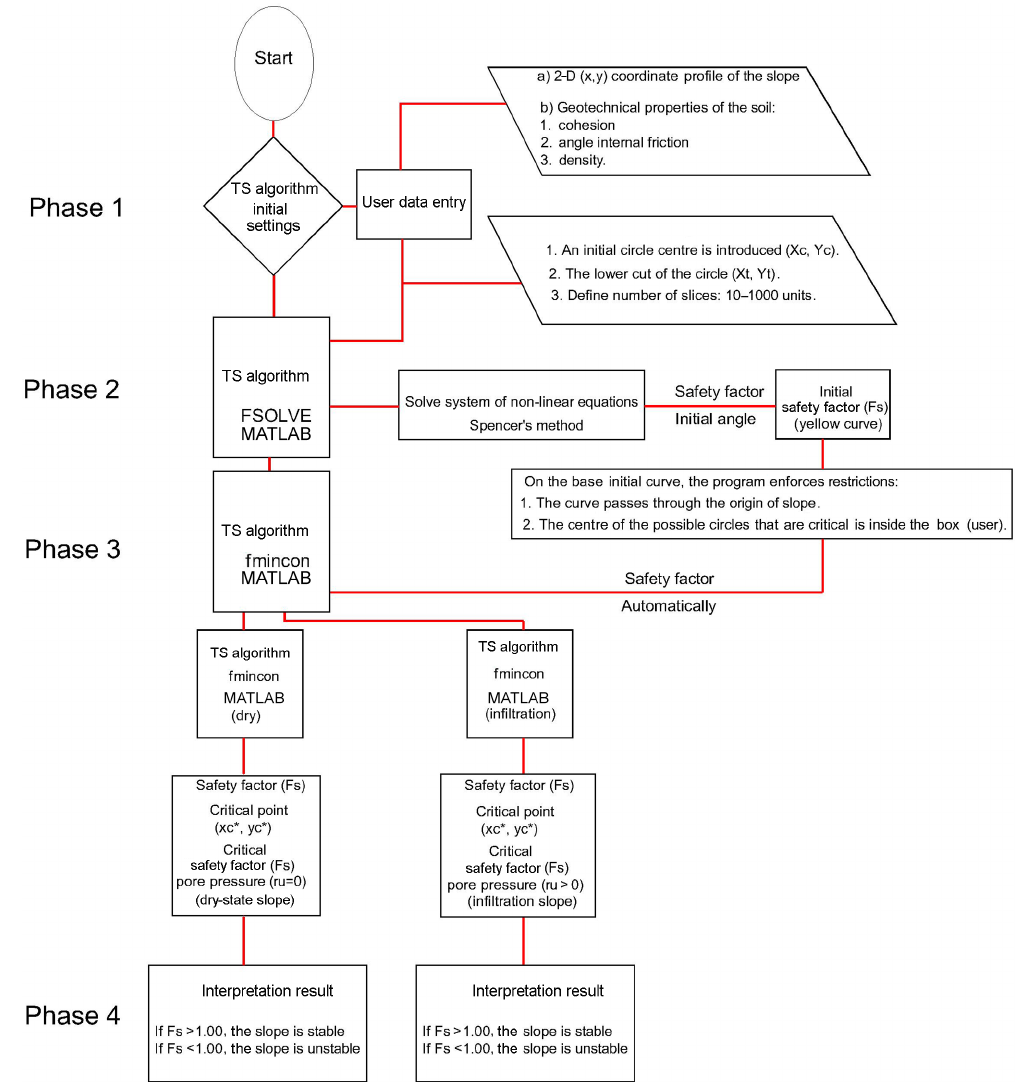
Figure 5. Sequential TS algorithm (block diagrams). Numbers in parentheses refer to numbers in the text.